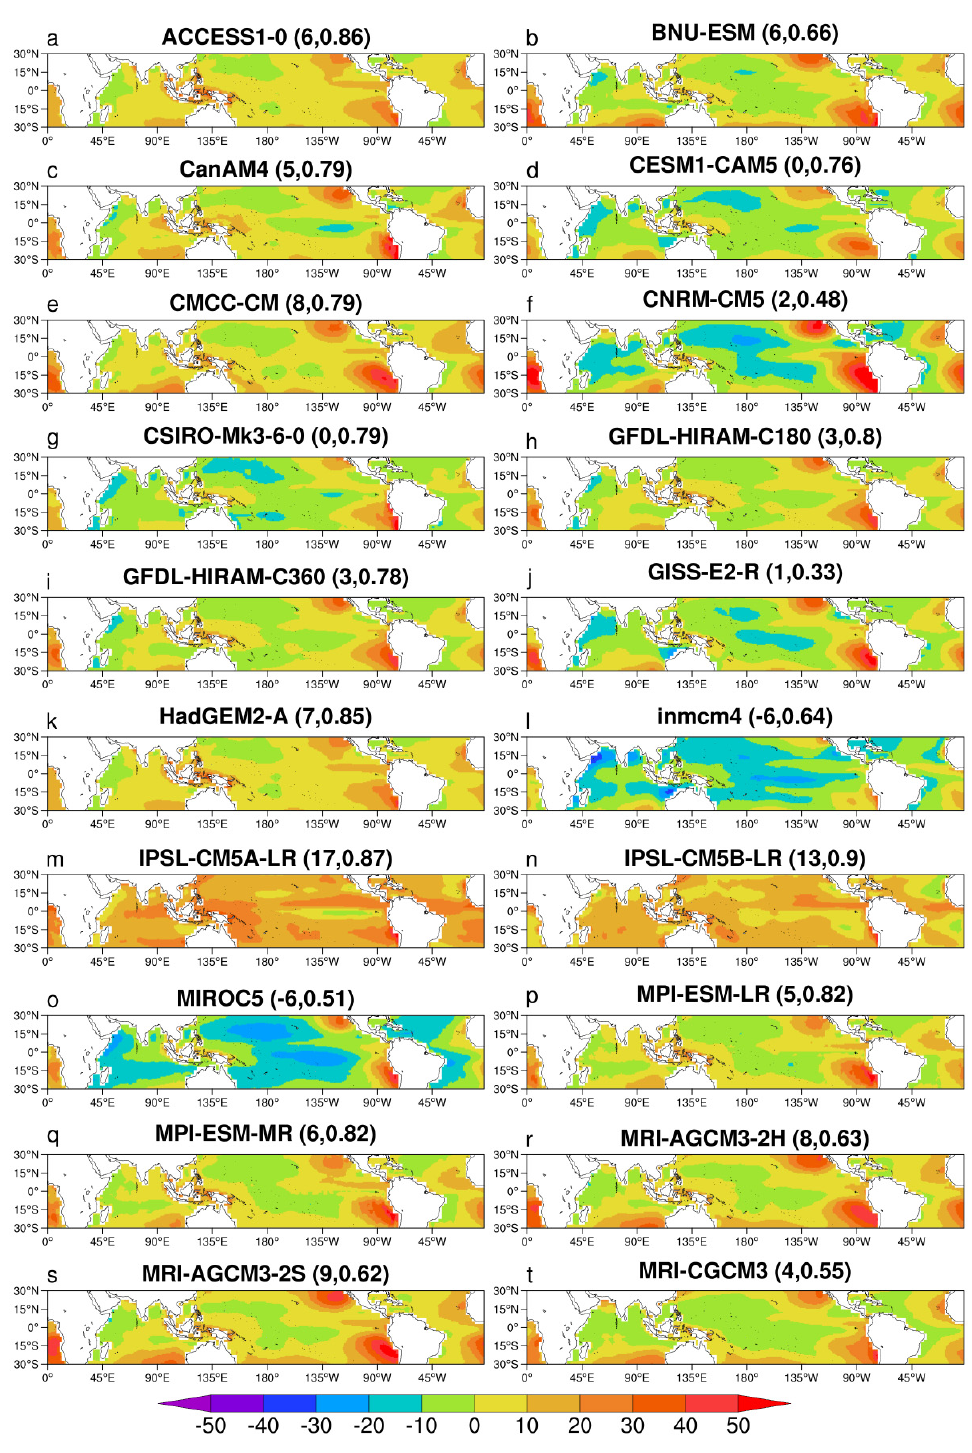
Figure 3. Mean bias in the net surface longwave Q LW estimated as a model minus the OAFLux over the tropical oceans. The numbers in the parentheses show the mean bias and correlation coefficient. (unit: W m − 2 ).